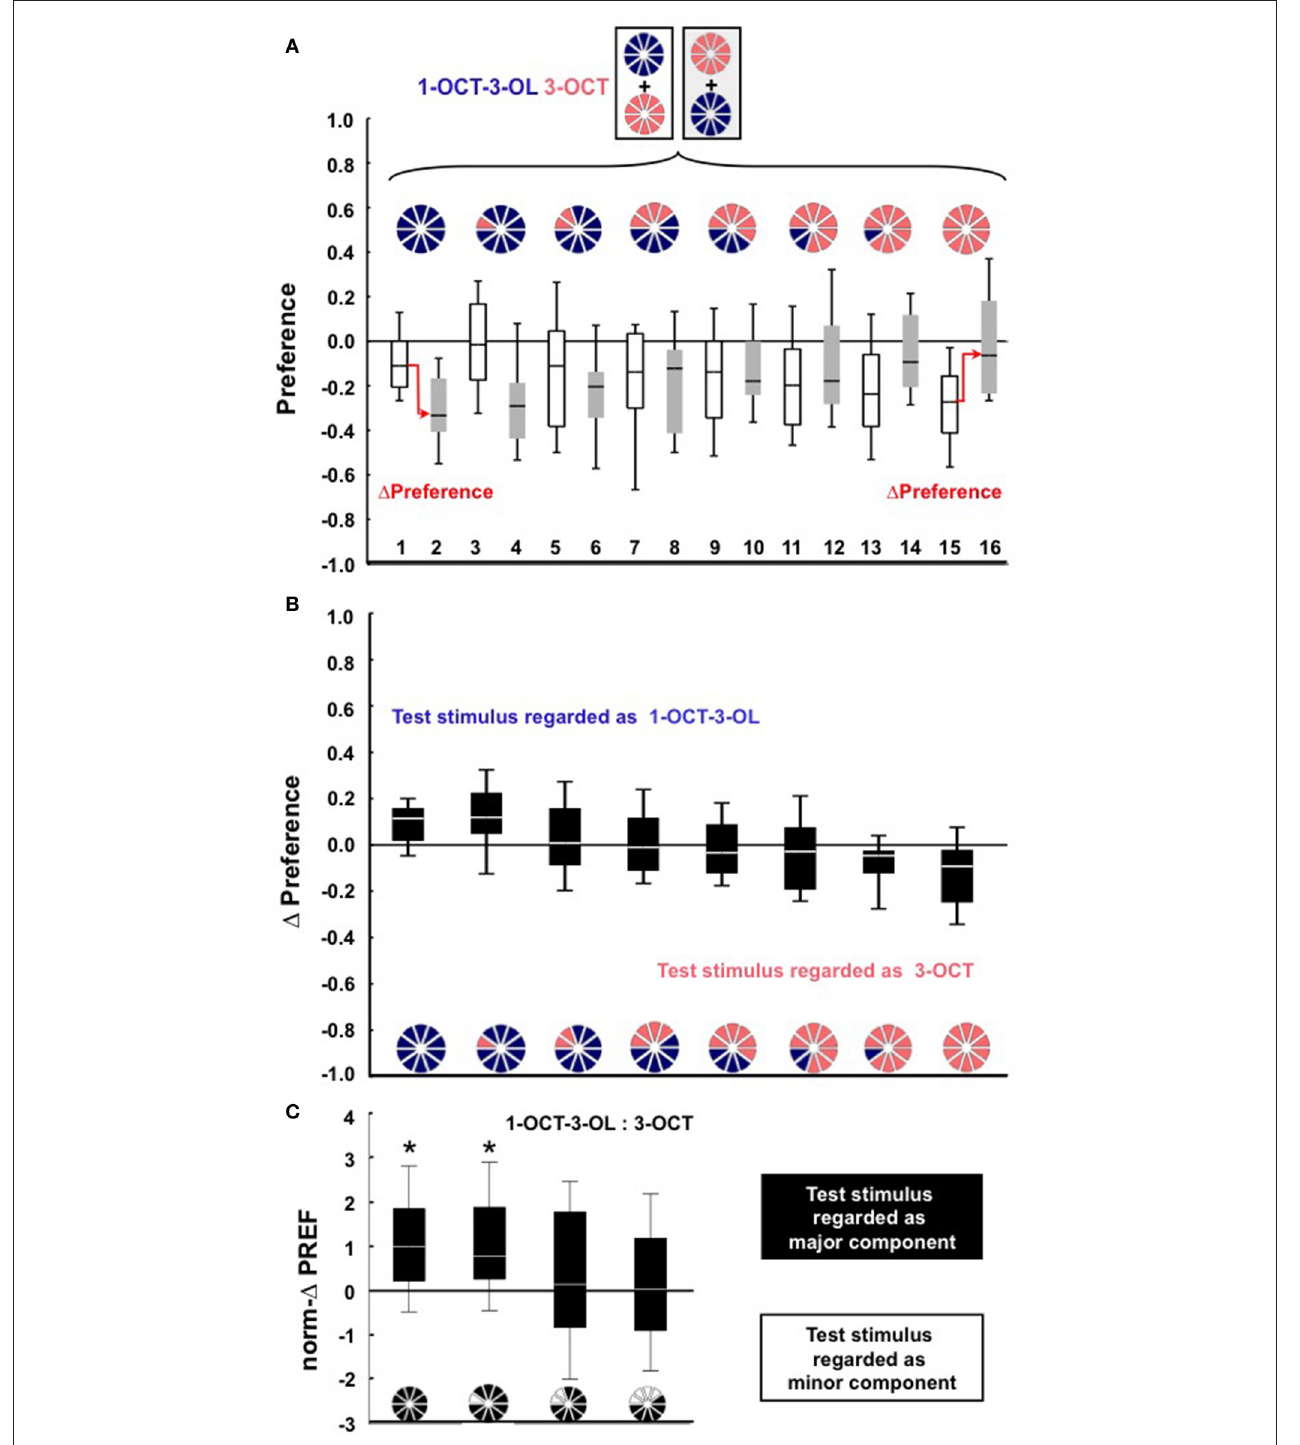
FIGURE 2 | (A–C) Same as in Figure 1 for the odor pair 1-OCT-3-OL and 3-OCT. In (A) Ns are 19, 19, 18, 18, 18, 18, 18, 18, 19, 19, 18, 18, 21, 21, 19, 19 from left to right. 1 Preference scores are displayed in (B) . Data in (C) differ across groups (KW-test, P < 0.05, H = 11.83, df = 3); asterisks above the box plots indicate P < 0.05/4 in W -tests for the norm- 1 PREF